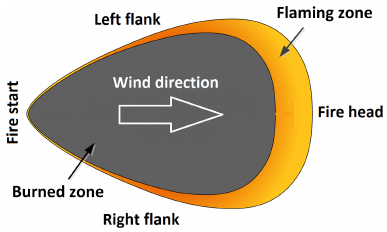
Figure 6. Wildfire spread in a hypothetical landscape. (a) Random ignition of a small fire in the landscape. (b) The small fire escalates as a wildfire. (c) The wildfire reaches an oil facility.